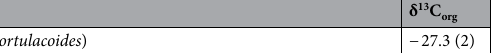
Source δ 13 C org Saltmarsh ( Halimione portulacoides ) − 27.3 (2) Seagrass ( Zostera noltii Table 2. C org isotopic signature (δ 13 C org ) and C:N ratio of potential sources to soil C org stocks measured in this study. N measurements indicated in brackets.